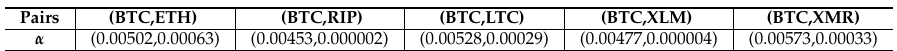
Table 5. Estimates of the speed of adjustment parameters α for all pairs. All estimates are 5% statistically significant.